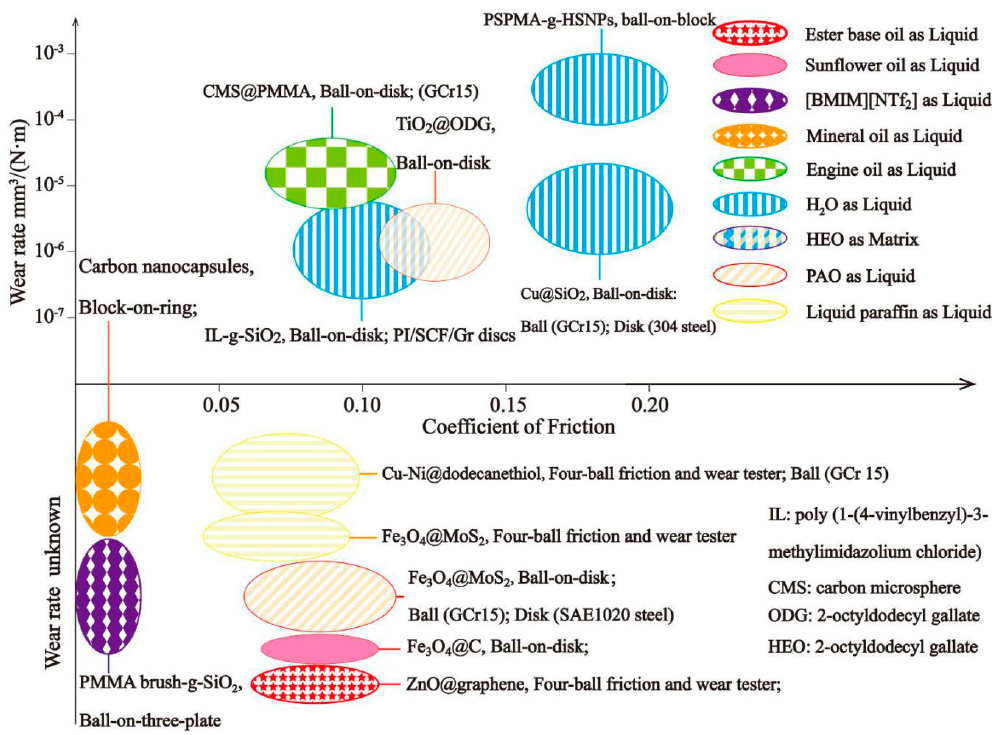
Figure 11. Tribological properties of different lubricating liquid enhanced by core–shell particles.